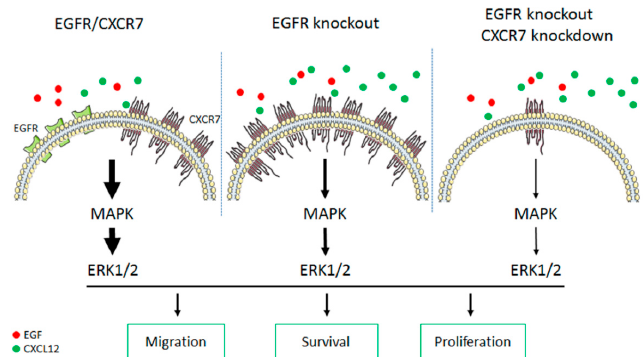
Figure 7. The proposed model of CXCR7-EGFR crosstalk and its effect on the MAPK signaling pathway. EGFR-ERK and CXCR7-ERK signaling pathways promote tumor cell development (left). Ablation of EGFR leads to overexpression of CXCR7/CXCL12 and subsequently stimulates the ERK pathway, resulting in tumor cell survival (middle). Dual inhibition of EGFR and CXCR7 further suppresses ERK signaling and synergistically inhibits tumor growth (right). Thickness of the arrow shows strength of the signaling. The number of solid dots (in red or green) shows the amount of the endogenous epidermal growth factor (EGF) or CXCL12.